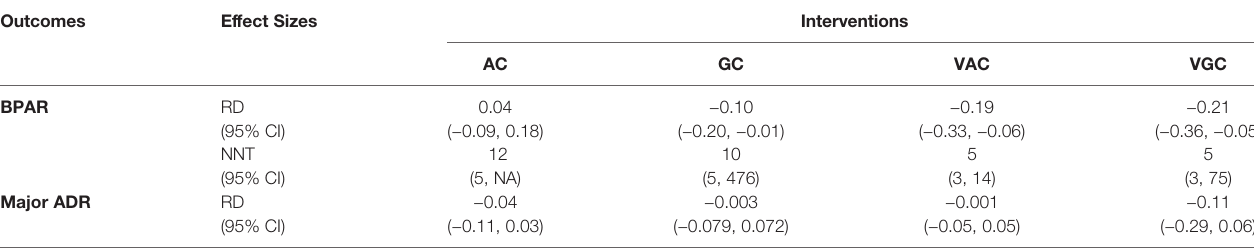
TABLE 2 | Pooled risk differences for the incidence of BPAR and major ADR among antiviral agents versus placebo/control.